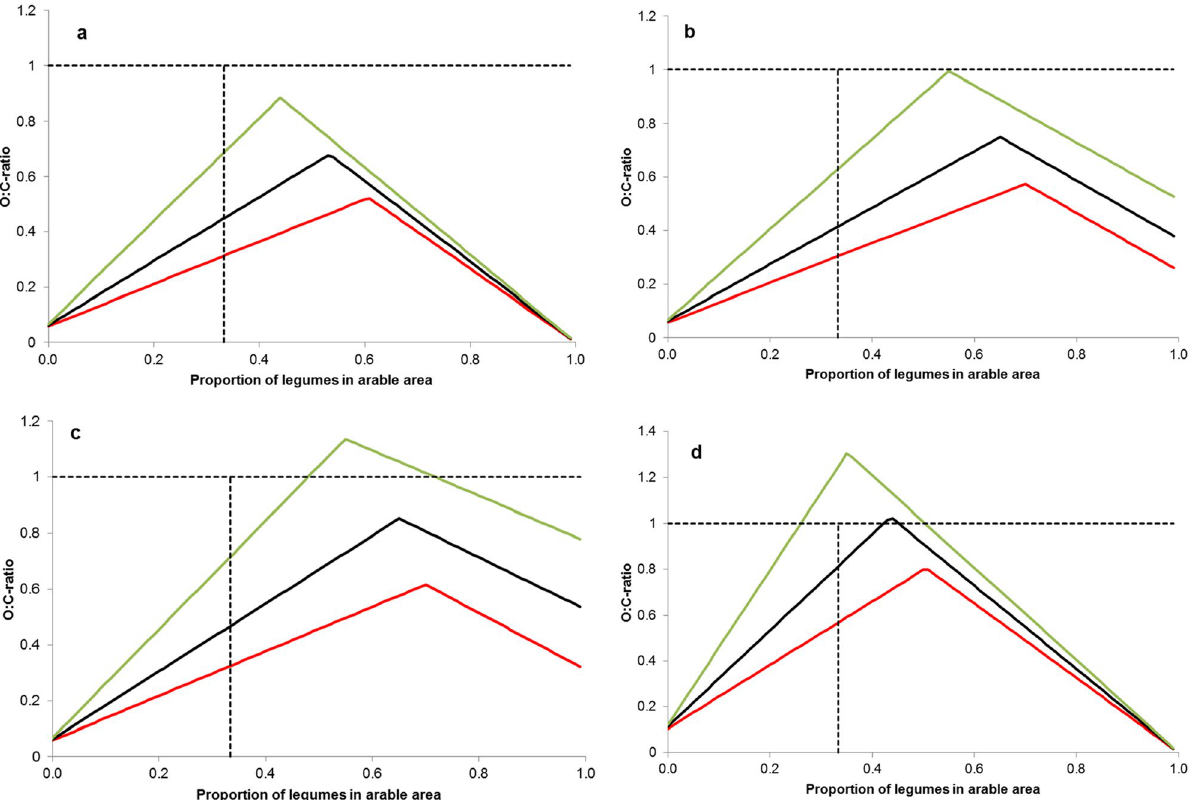
Figure 4. Modeled maximum O:C ratio depending on proportion of legume in arable area. Optimistic scenario (green lines), realistic scenario (black lines), pessimistic scenario (red lines). Dashed vertical line indicates recommended proportion of forage legumes in rotation. O:C ratio calculated for cereal yield only ( a ), total energy output from wheat and forage legume via conversion to milk ( b , d ); and for total protein yield ( c ); references level of high ( a – c ) and lower ( d ) conventional wheat yield